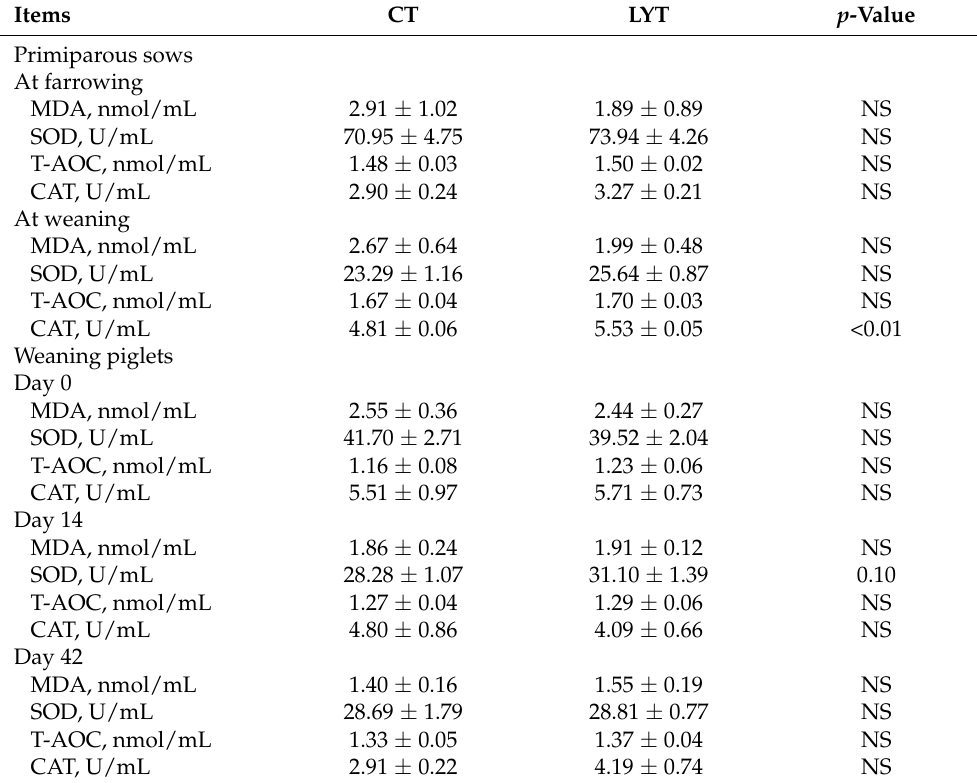
Table 8. The effects of live yeast supplementation during late pregnancy and lactation period on antioxidant parameters in the plasma of primiparous sows and weaned